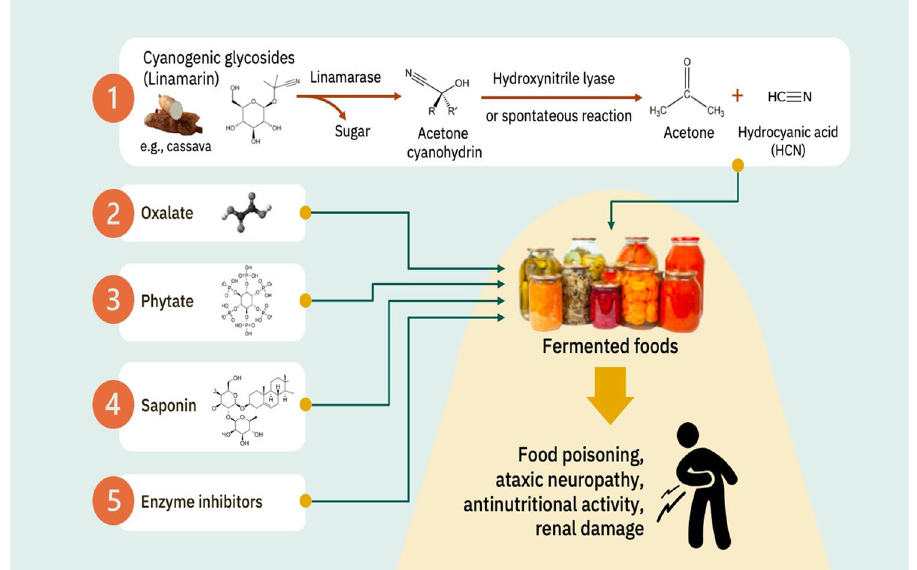
Fig. 4 Plant toxins from substrates to fermented foods. Illustrations adapted from Adobe stock images (http://stock.adobe.com/) under Standard